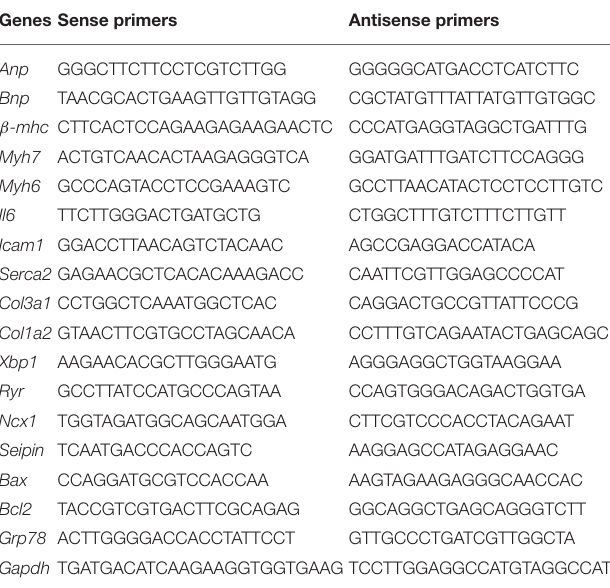
TABLE 1 | Primers used in real-time polymerase chain